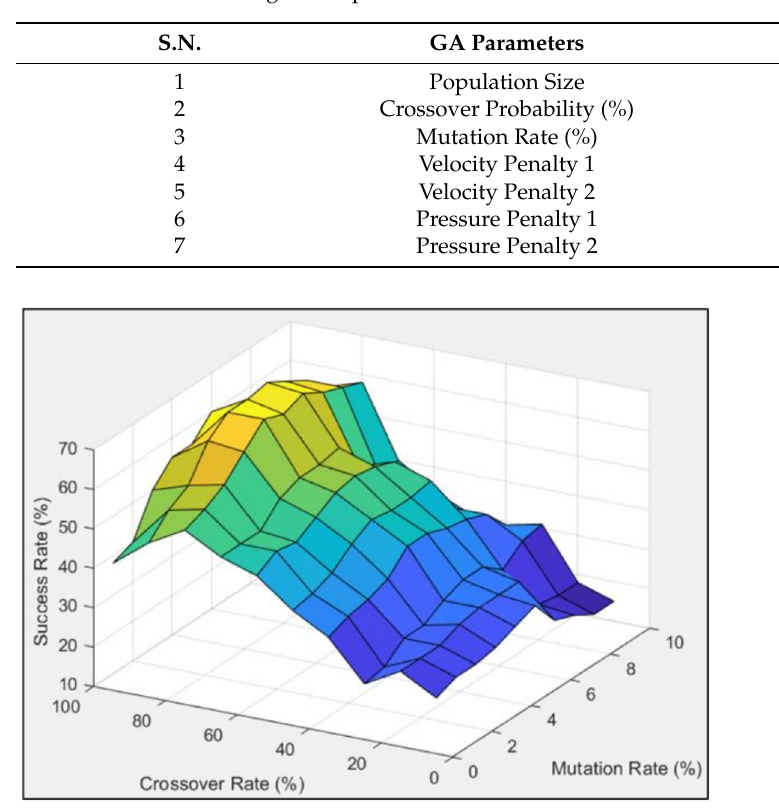
Figure 5. Sensitivity analysis